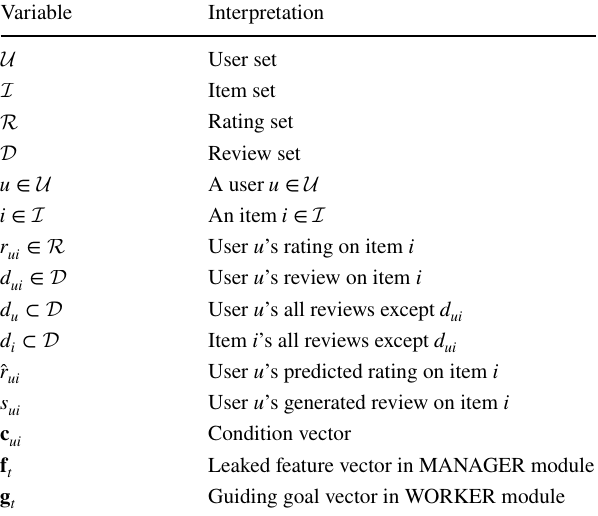
Table 1 Notations used in this paper